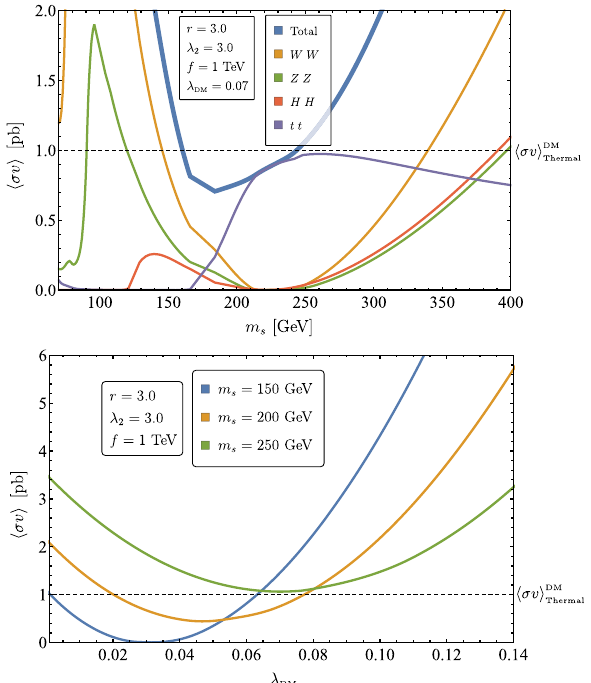
Fig. 5 Left panel: The thermally averaged cross section as a function of the DM mass m s for λ DM = 0 . 07 , f = 1000 GeV , r = 3 and λ = 3. The dashed line at (cid:4) σv (cid:5) = 1 pb represents the cross section 2 that produces the correct relic abundance according to Eq. (107). Right panel: The thermally averaged cross section as a function of λ DM for different values of m s with f = 1000 GeV , r = 3 and λ 2 = 3. The dashed line at (cid:4) σv (cid:5) = 1 pb represents the cross section that produces the correct relic abundance according to Eq.